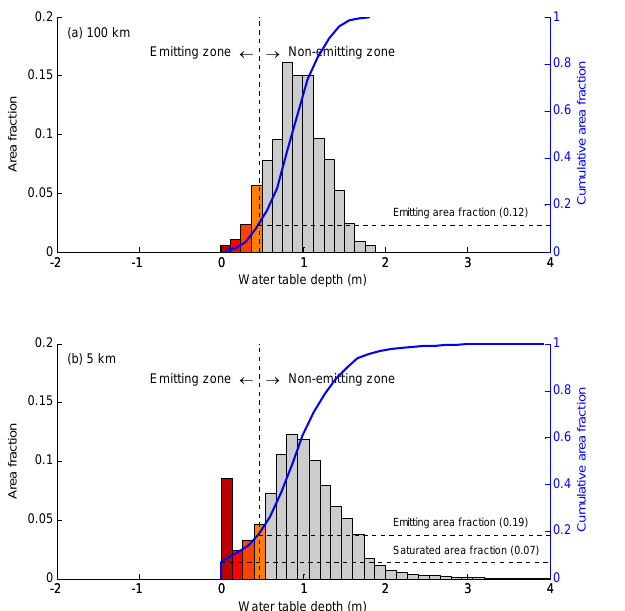
Fig. 5. Probability distributions of mean water table depth dur- ing the growing season (May–September) at 100km (a) and 5km (b) spatial resolutions across West Siberian Lowlands. The colored and grey bars indicate methane-emitting and non-emitting zones, respectively; darker colored bars correspond to higher methane- emitting rates.